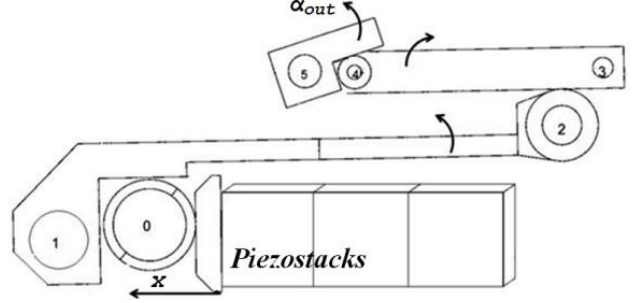
Figure 7. The mechanical amplification